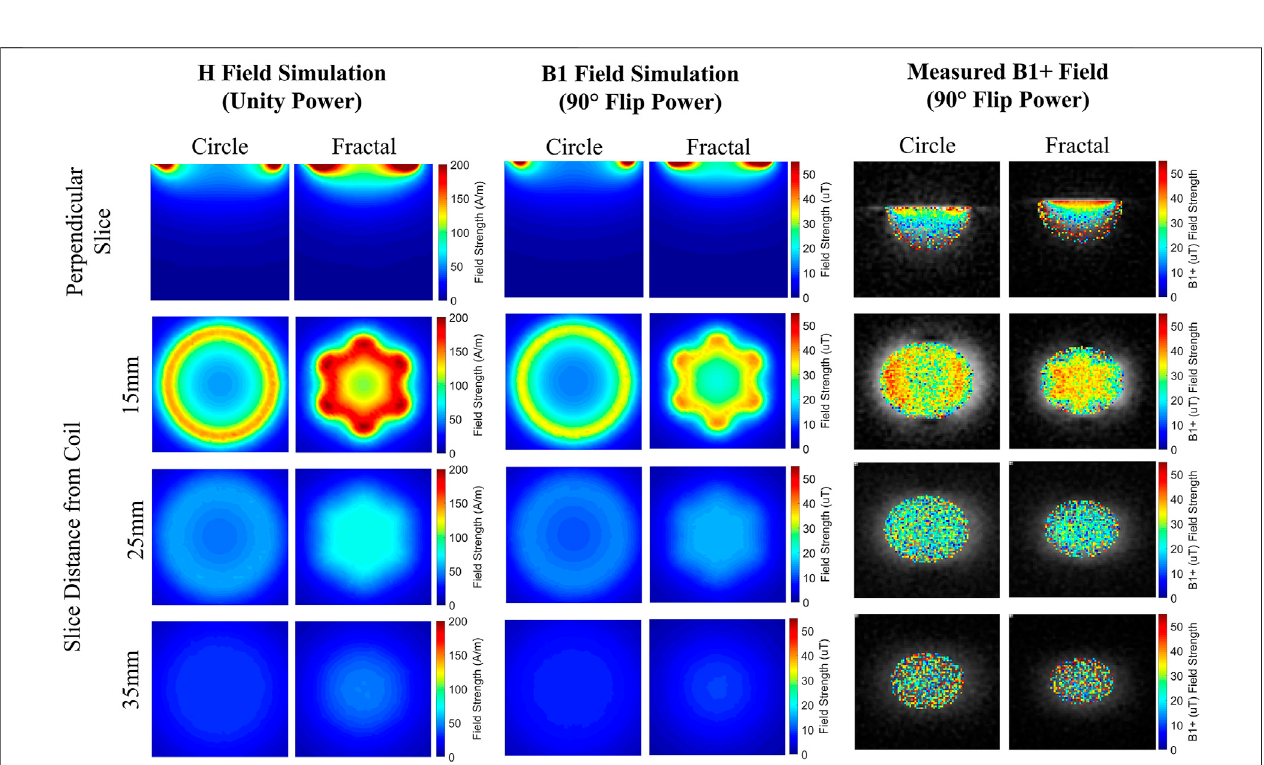
FIGURE5| TheexperimentalB 1+ fi eldmapsofthecircularandfractalcoil,alongsideeachmapssimulatedcounterpartatthesameslicelocation.ThesimulatedB1 fi eld maps and the measured B 1+ fi eld maps are given in μ T and the simulated H fi eld maps are given in A/m.